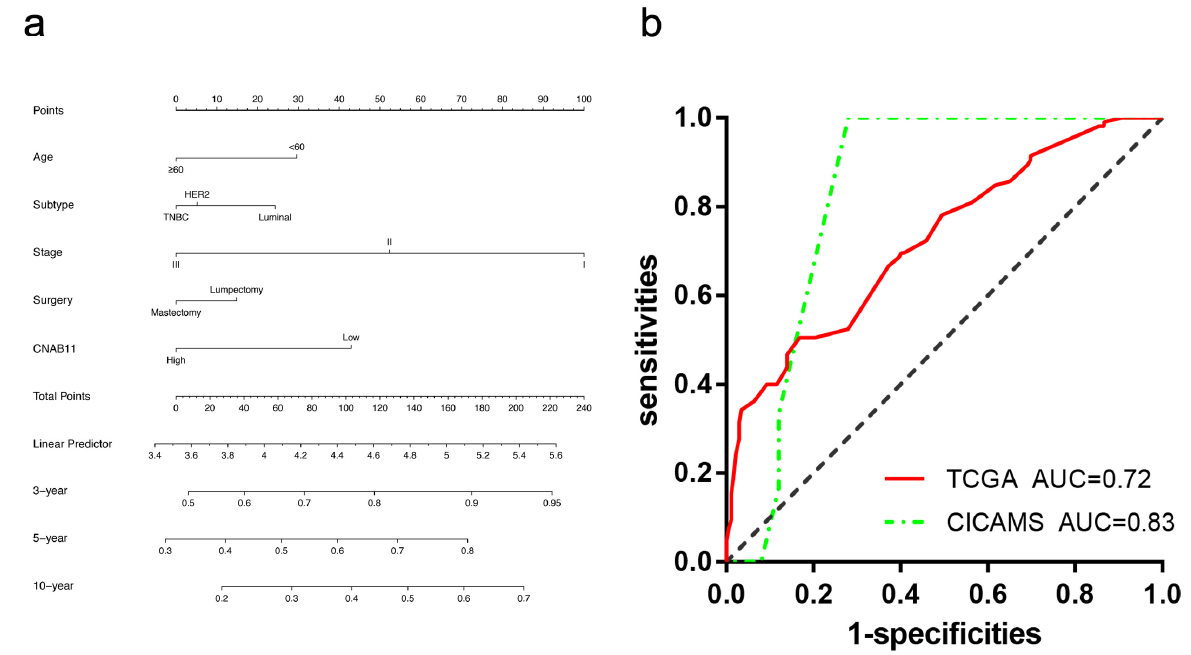
Figure 4. ( a ) Nomogram of early-stage breast cancer based on CNAB11 score and clinical characteris-